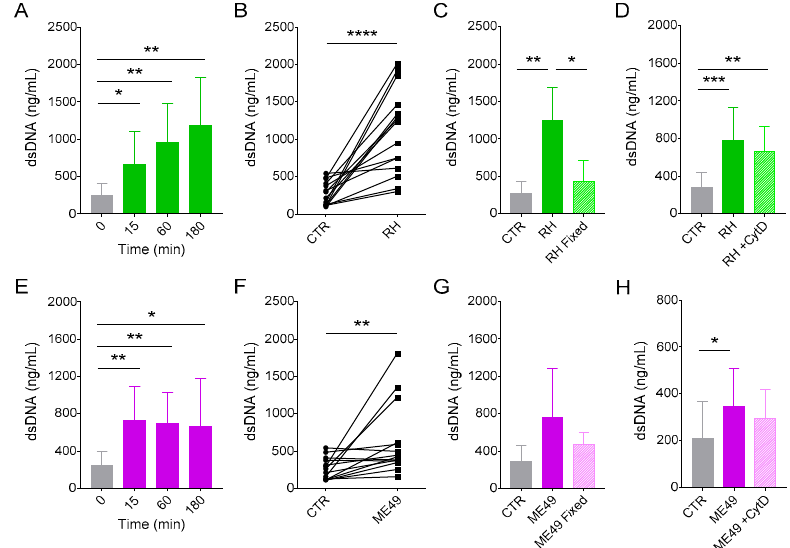
Figure 1. Toxoplasma gondii induce neutrophil extracellular trap (NET) release from cat neutrophils. Neutrophils from several donors were incubated for the indicated time intervals in the absence (CTR) or presence of tachyzoites from ( A ‐ D ) RH or ( E ‐ H ) ME49 strains (5:1 parasites:neutrophil ratio). Supernatants were collected and released dsDNA was quantified with PicoGreen Kit. ( A , E ) Release of NET from feline neutrophils is strain- and time-dependent ( n = 10–12). ( B , F ) Interdonor variations in dsDNA release after 180 min incubation with parasites ( n = 14–15). ( C , G ) NET induction by paraformaldehyde-fixed or live parasites after 180 min incubation ( n = 8–9). ( D , H ) Formation of NET does not require invasion of neutrophils by the parasites. Cat neutrophils were pretreated or not with cytochalasin D (CytD; 10 µ g / mL) for 30 min and then stimulated with T. gondii tachyzoites ( n = 5–12). All results are shown as mean (SD). * p < 0.05; ** p < 0.01; *** p < 0.001; **** p < 0.0001.